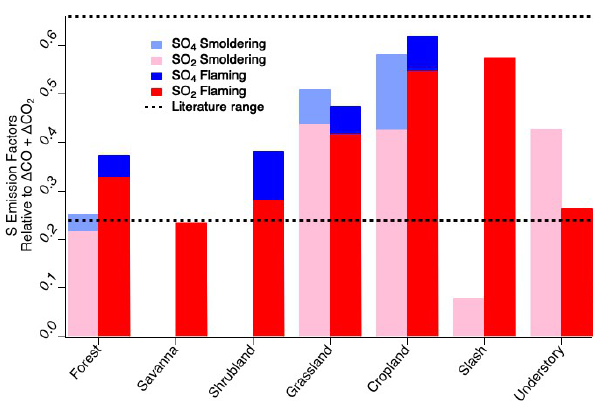
Figure 2. Elemental sulfur emission factors of SO 2 and sulfate by fuel type and combustion stage within 1h downwind compared to literature values of total sulfur emission